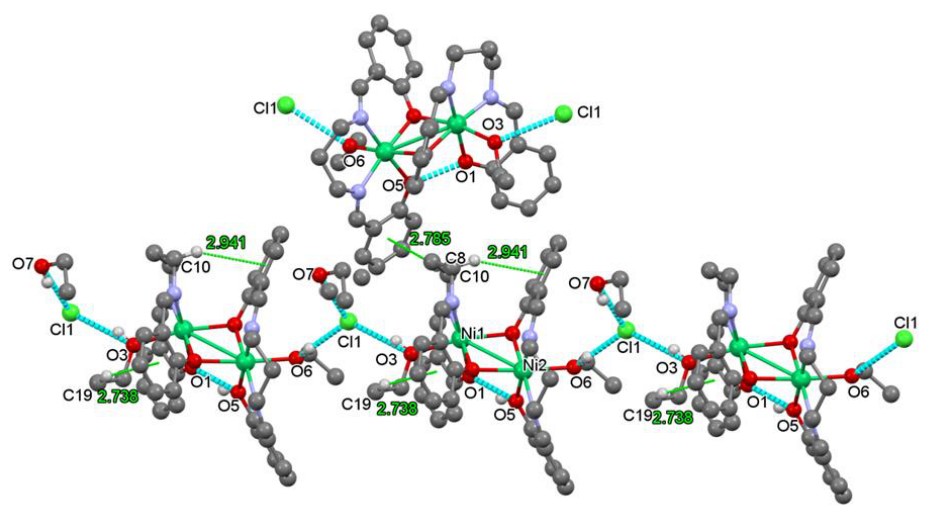
Figure 4. Crystal packing for the [MHL 2 (EtOH) 2 ].(Cl).(EtOH) showing molecules linked by O–H. . . Cl hydrogen bonds as dashed blue lines and C–H. . . π interaction as green lines.